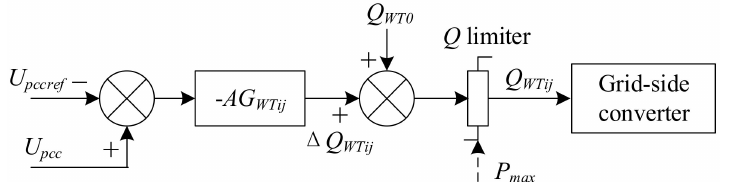
Figure 10. The control block diagram of the reactive power controller adaptive gain scheme for